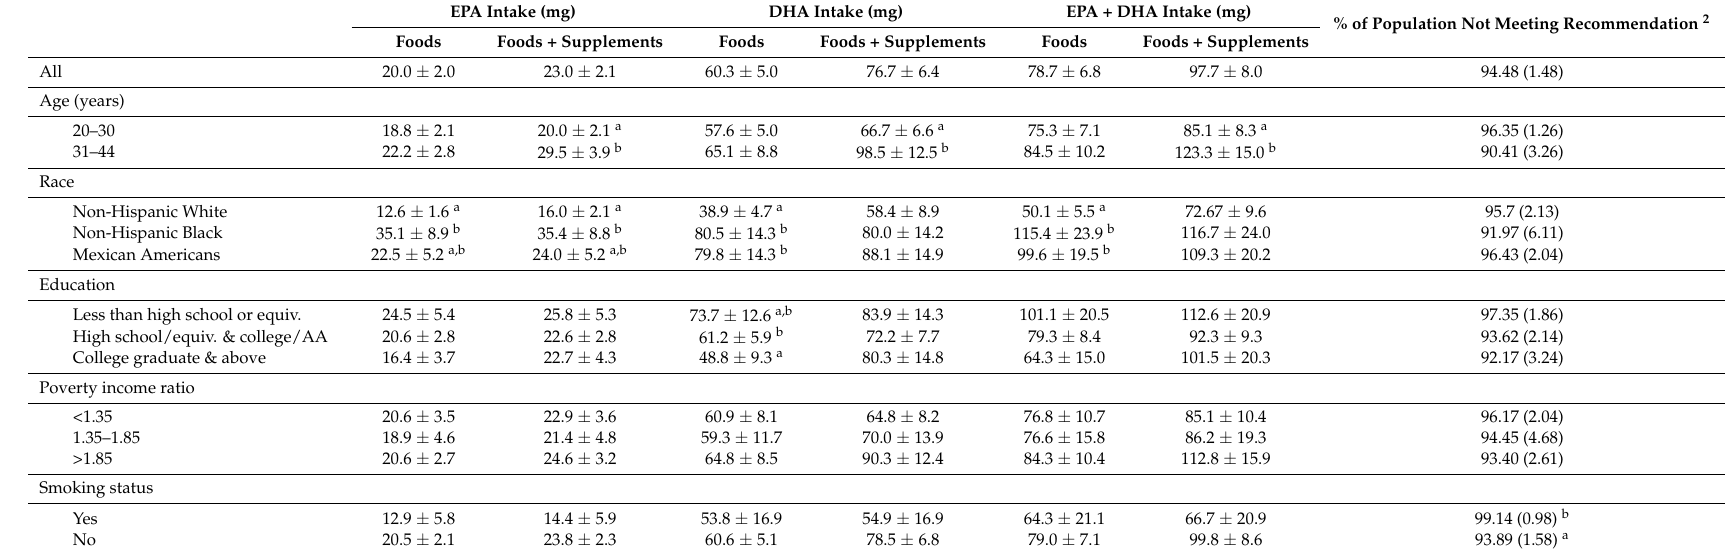
Table 6. Mean usual daily intake of EPA and DHA from foods alone, and from foods and dietary supplements among pregnant women for a fully qualified sample 2001–2014